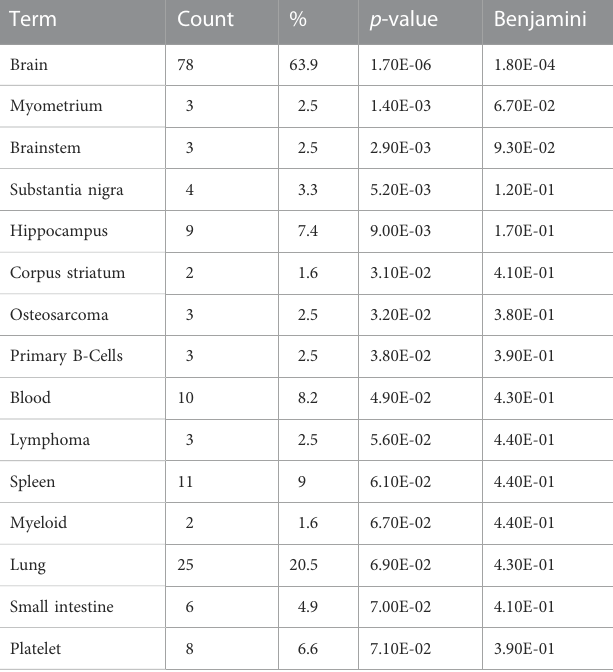
TABLE 6 Enriched UniProt Tissue Expression – Shrew Emesis Genes. Enrichment UniProt tissue expression analysis performed on the set of 125 shrew ( Cryptotis parva ) candidate genes for emesis. Term corresponds to the speci fi c enriched interacting protein, count indicates how many genes within the 125 candidate